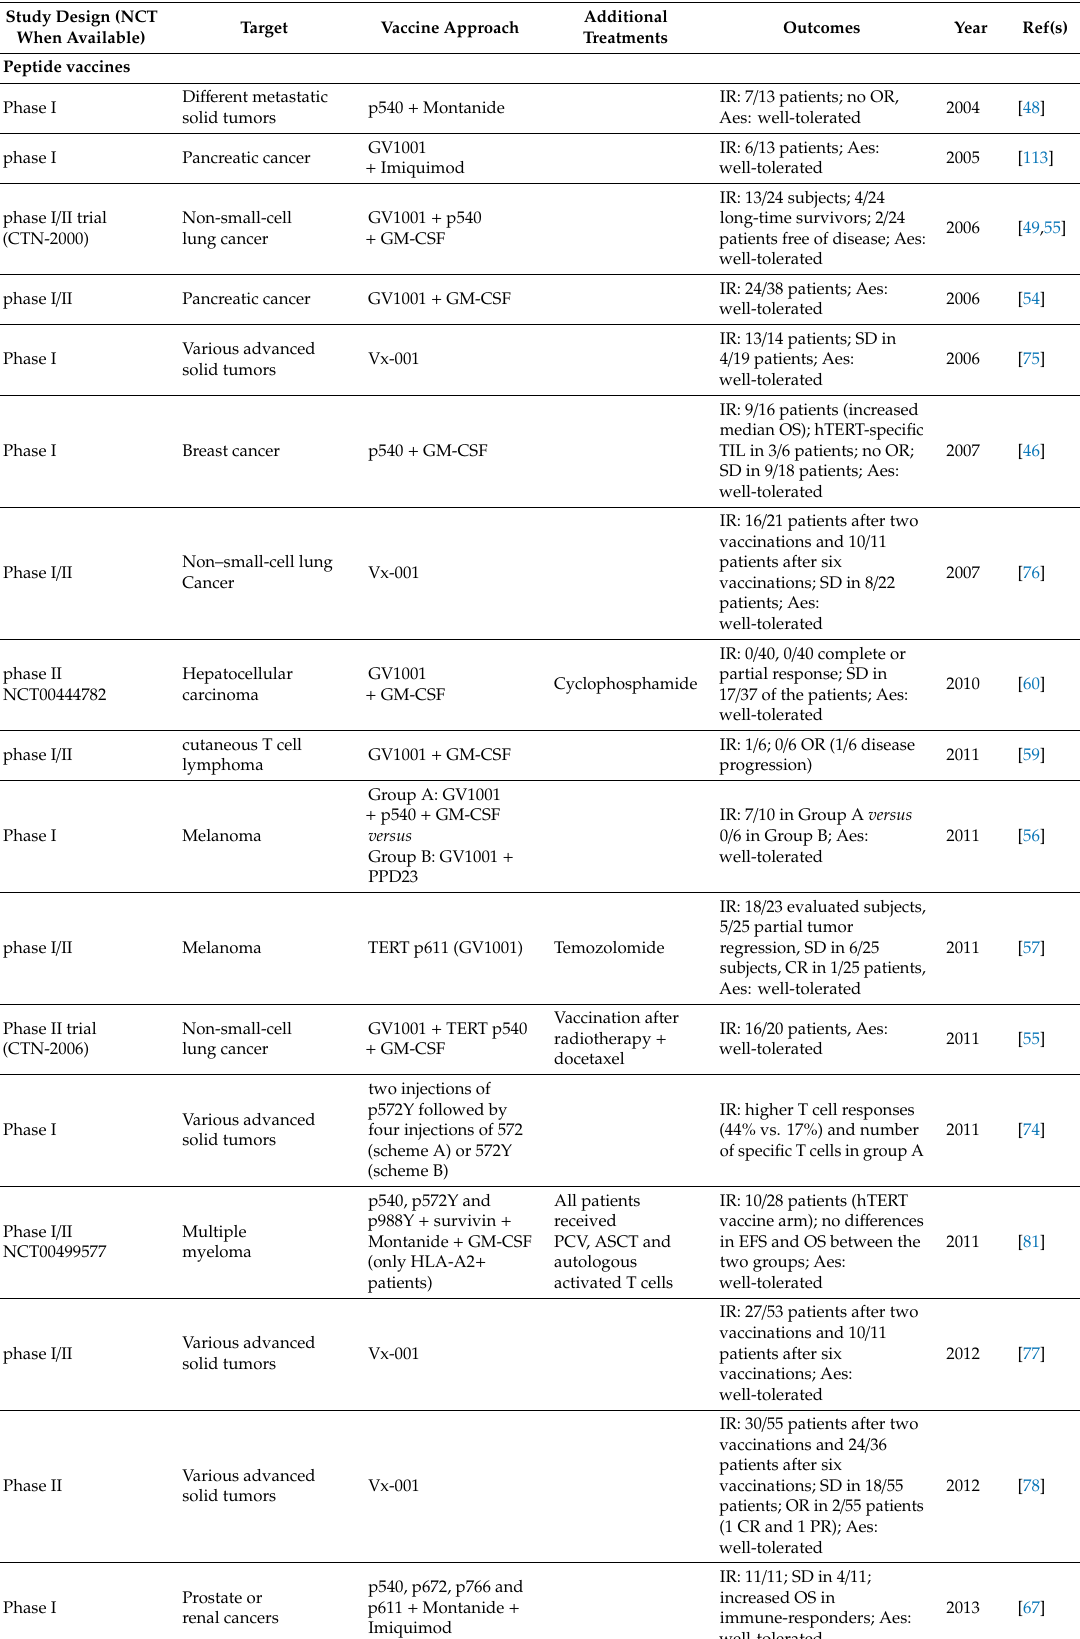
Table 1. Clinical trials on human telomerase reverse transcriptase (hTERT)-targeting immunotherapies. Study Design (NCT When